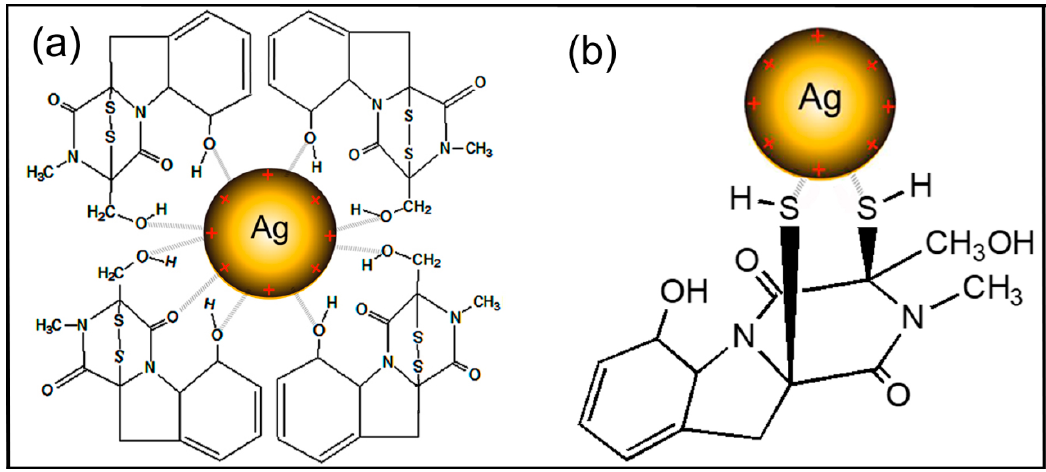
Figure 8. Schematic illustration showing the interactions between the oxidized ( a ) or reduced ( b ) form of gliotoxin with the surface of positive charge of silver nanoparticles (AgNPs).